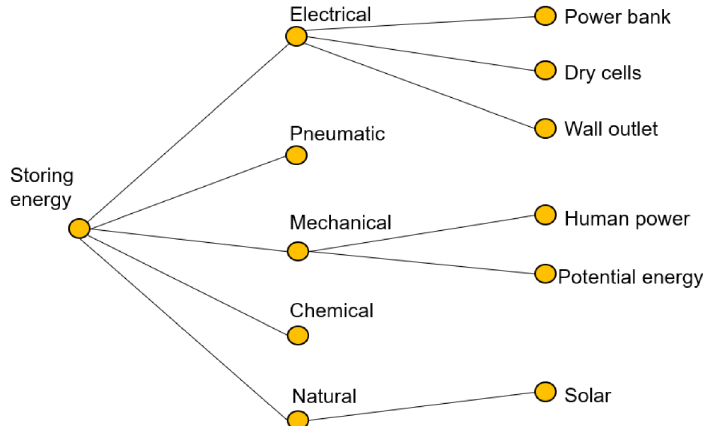
Figure 14. Classification tree for subfunction of storing energy.